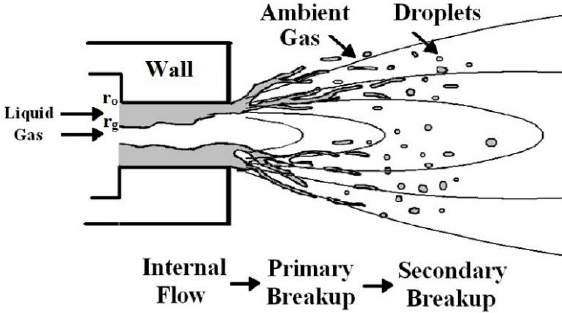
Figure 1. The schematic of liquid atomization.